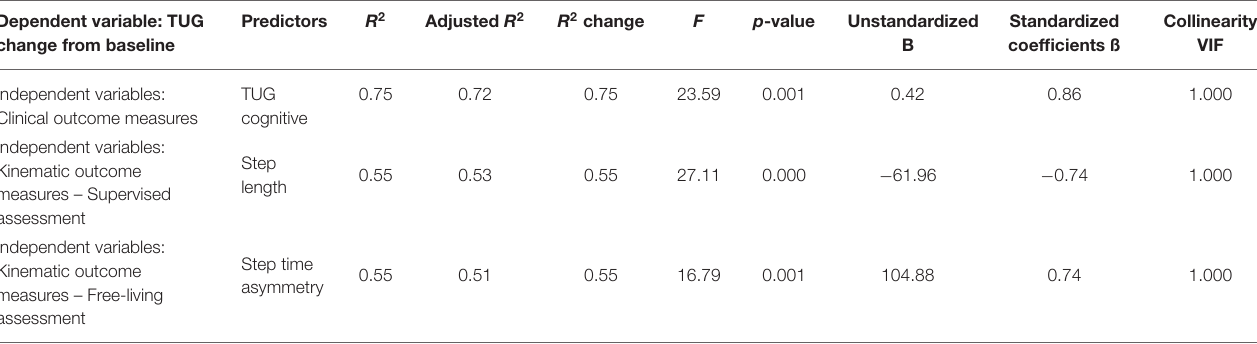
TABLE 3 | Stepwise multiple linear regression analysis with TUG as a dependent variable and (1) the clinical outcome measures, (2) gait parameters assessed during the 10-meter walk test, in supervised conditions, (3) gait parameters assessed in free-living conditions and analyzed in bouts longer than 60s, as independent variables. Dependent variable: TUG change from baseline